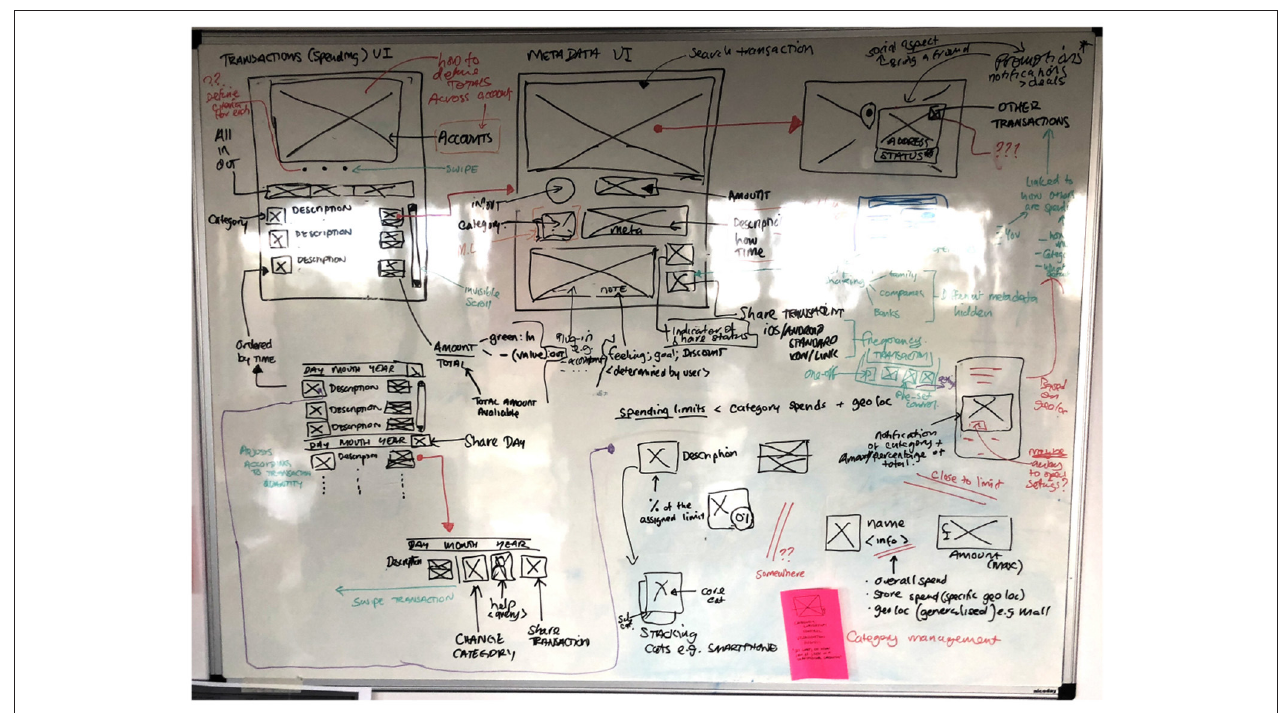
FIGURE 6 | Pre-COVID-19 exemplar sketching in UX design: demonstrating an ideation technique using a whiteboard. Makayla Lewis,